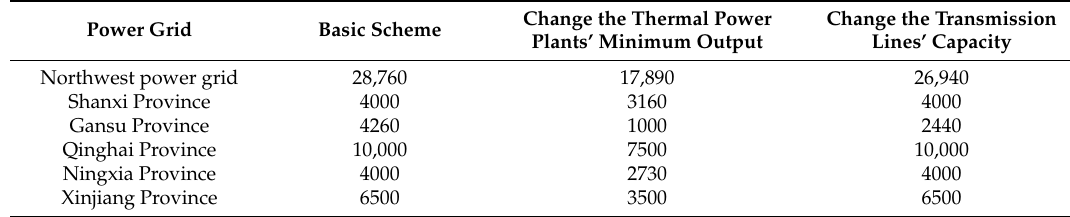
Table 5. Local accommodated power of PV power considering sensitivity analysis